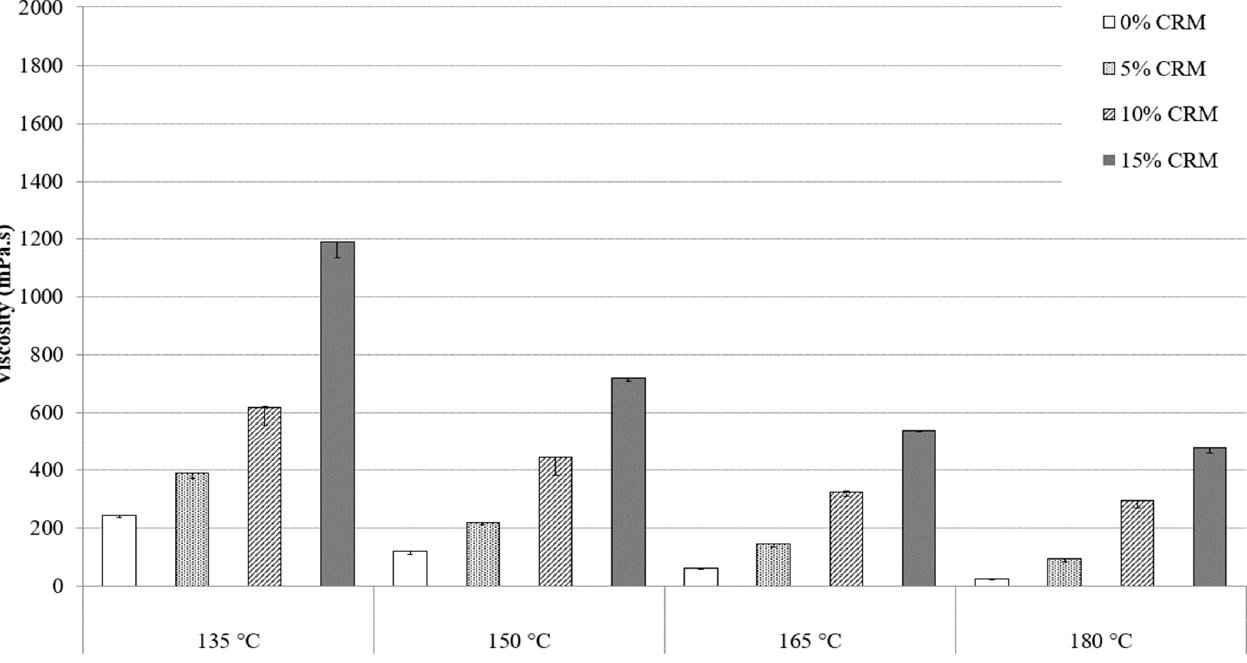
Table 4. Statistical analysis results of viscosity for PG 64-22 with 6% processed oil as a function of CRM content ( α = 0.05).